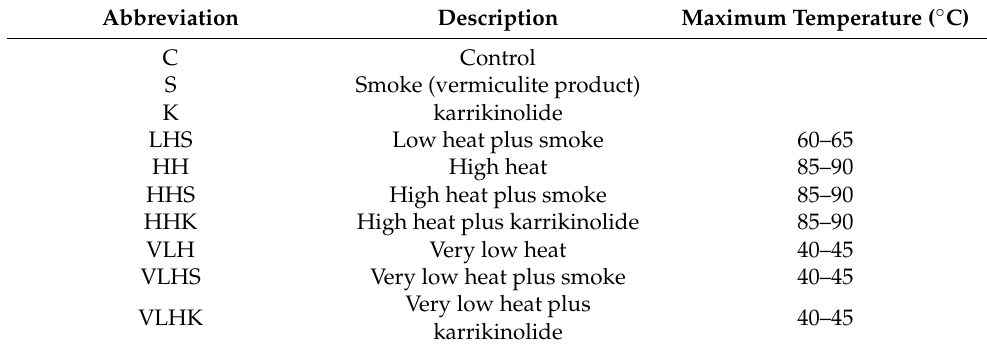
Table 1. Soil seed bank